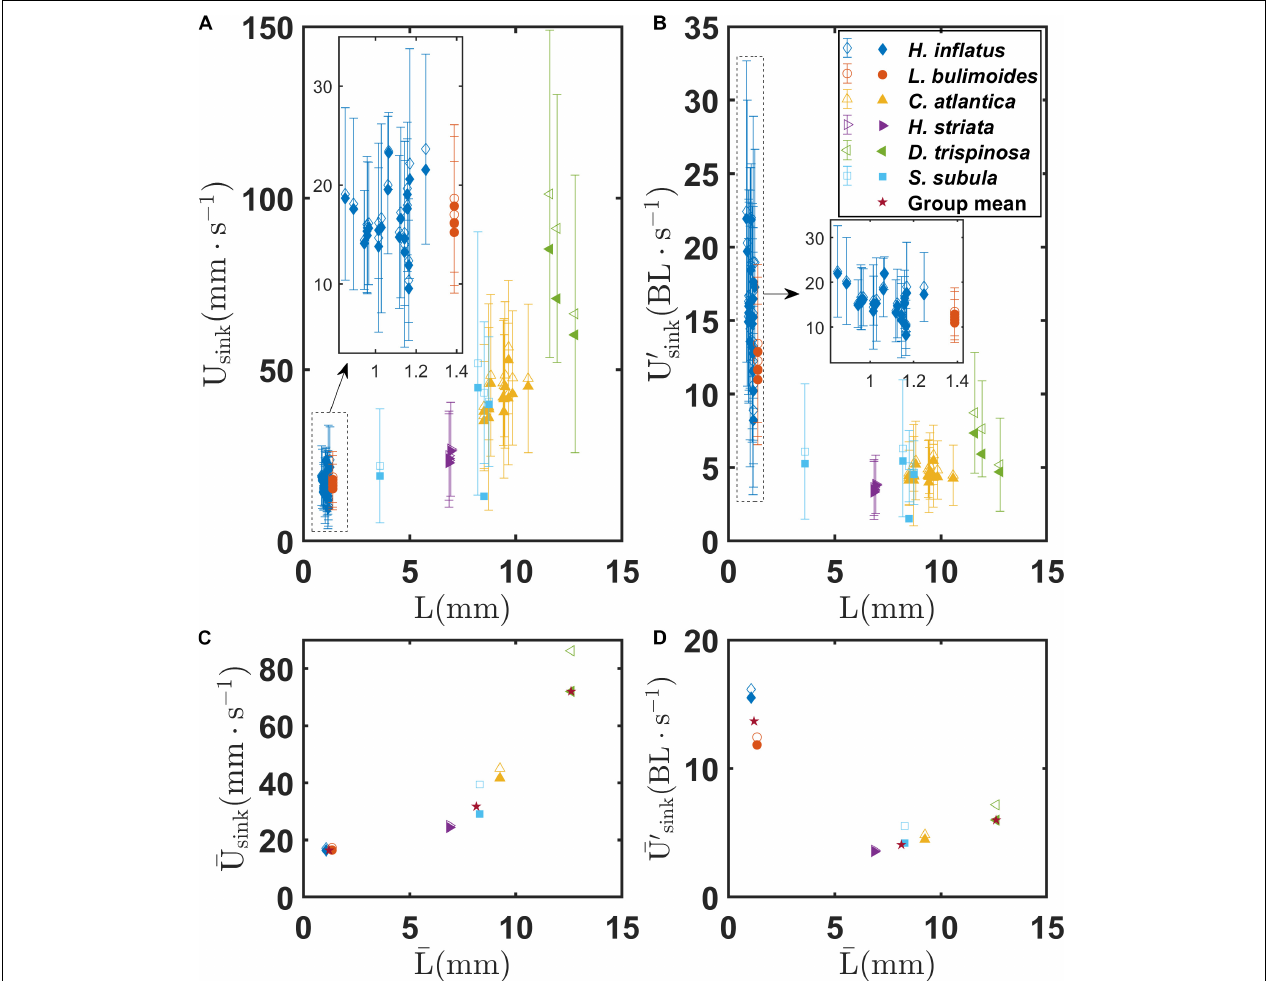
FIGURE 7 | (A) Mean and standard deviation of sinking speed U sink of individual marine snails as a function of body length L for various marine snail species. (B) Normalized mean and standard deviation of sinking speed U (cid:48) sink of individual marine snails as a function of body length L for various marine snail species. (C) Mean sinking speed ¯ U sink of various marine snail species as a function of mean body length ¯ L . (D) Mean sinking speed ¯ U (cid:48) sink of various marine snail species as a function of mean body length ¯ L . Stars in (C,D) indicate group means of coiled, elongated, and globular shelled thecosome